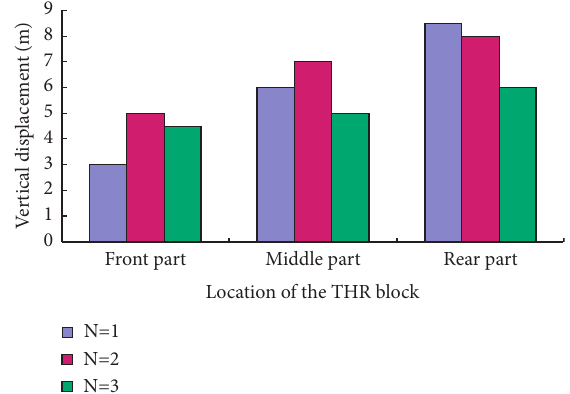
Figure 13: Distribution of vertical displacement of surrounding rocks under different immediate roof filling